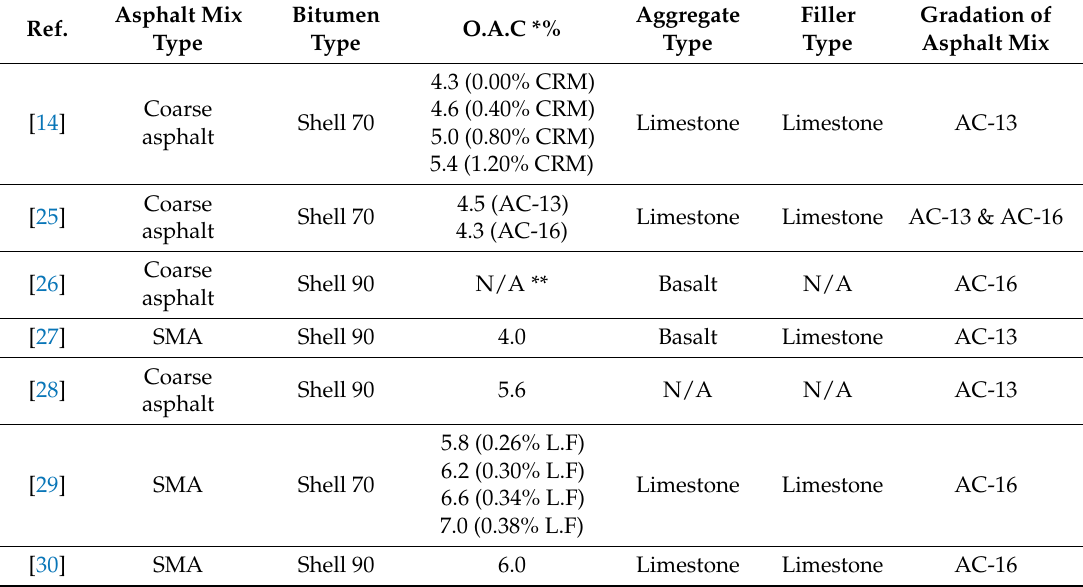
Table 3. Component of asphalt mixes modified with lignin fiber [14,25–30].